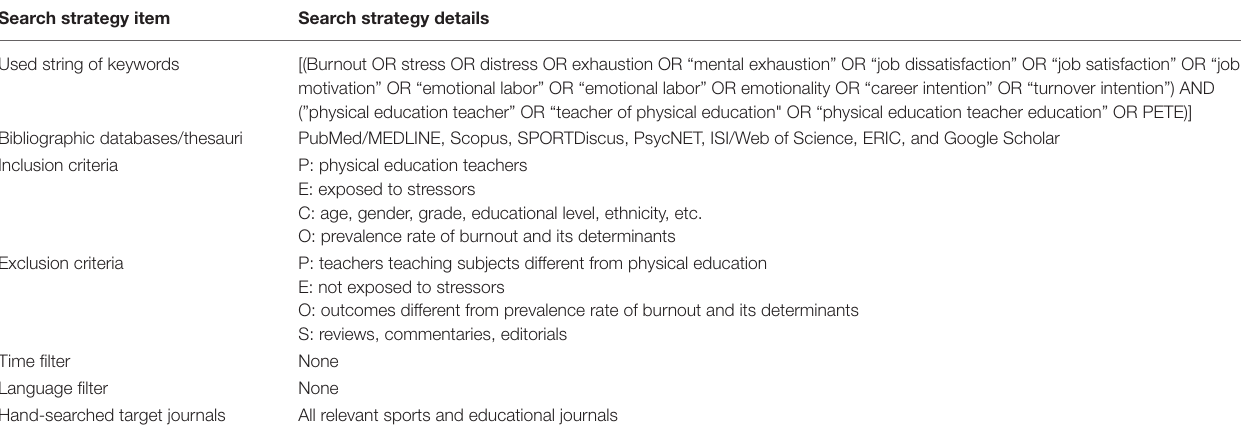
TABLE 1 | Search strategy adopted in the present systematic review and